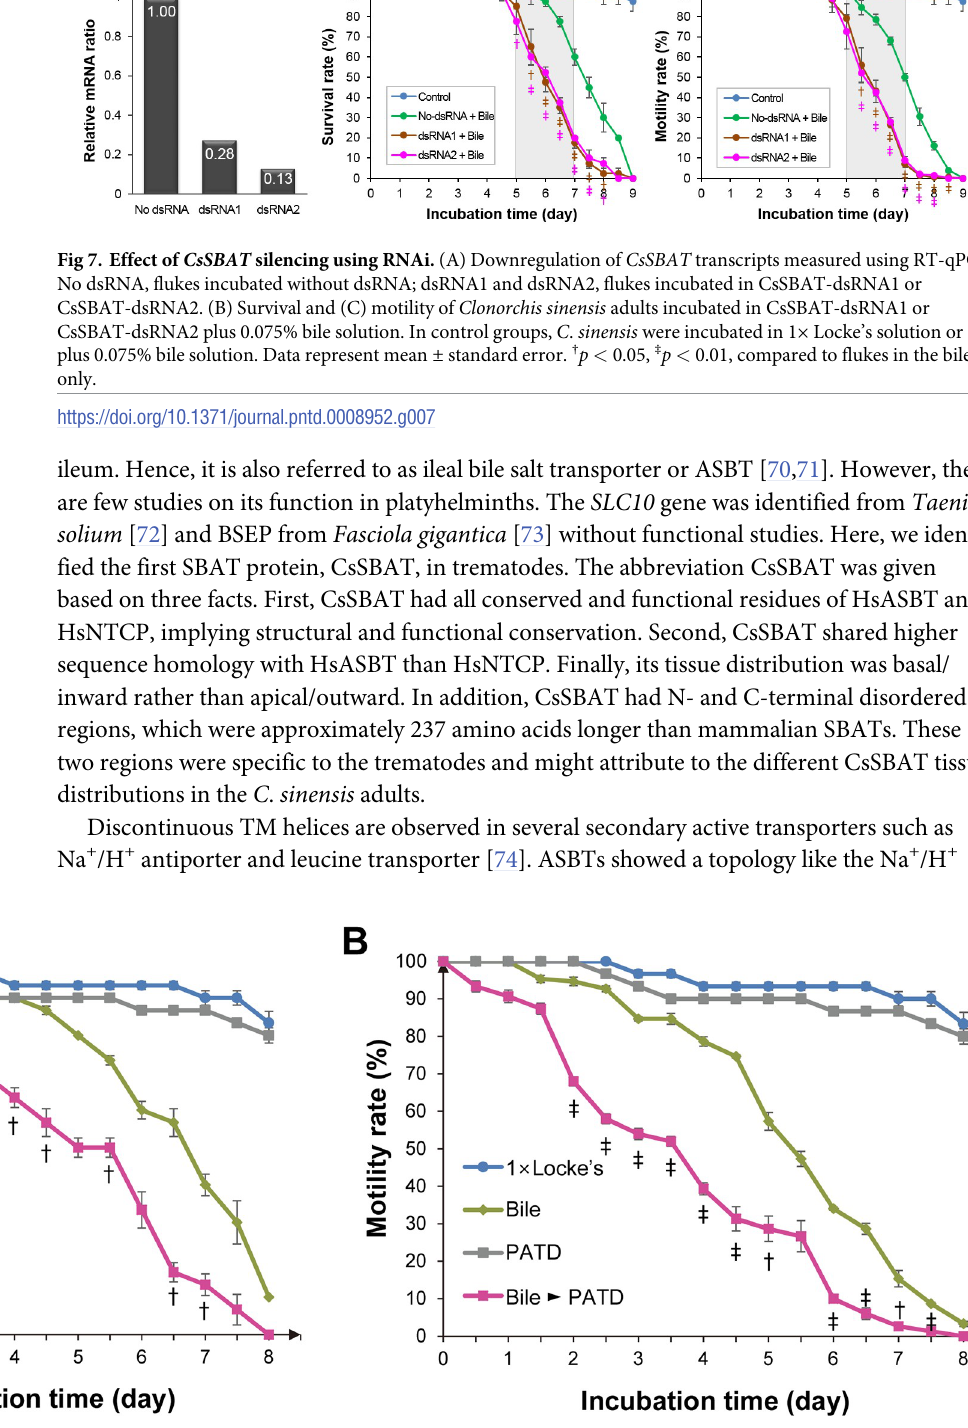
Fig 8. Survival and motility of C . sinensis adults in the bile with polyacrylic acid–tetradeoxycholic acid conjugates (PATD). (A) Survival curve. (B) Motility curve. Bile concentration, 0.075%; PATD concentration, 100 μ g/mL. Data represent mean ± standard error. † p < 0.05 and ‡ p < 0.01 compared to the bile group.